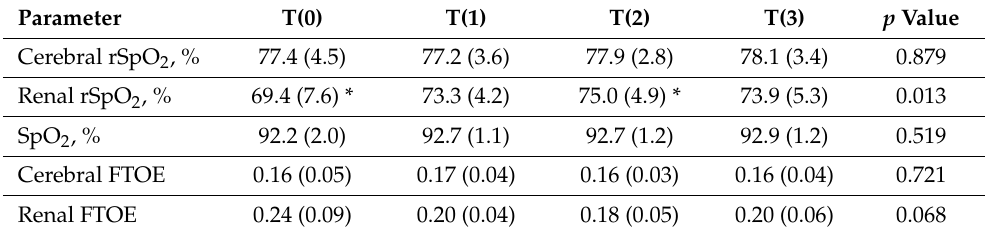
Table 3. NIRS and SpO 2 measurements at different time